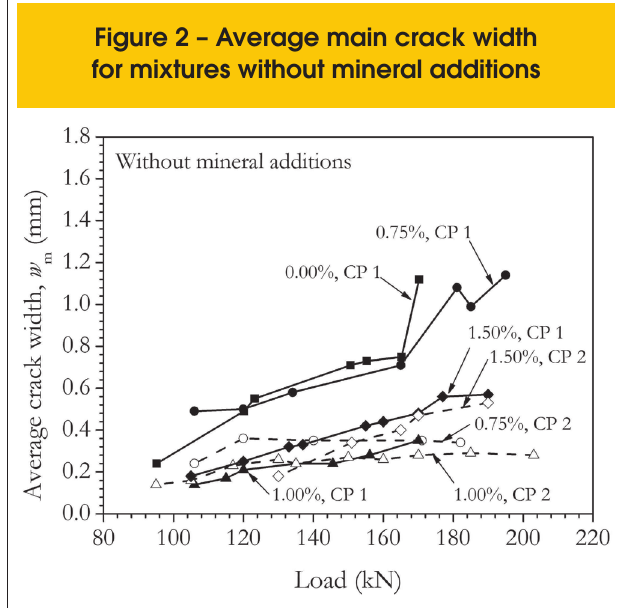
Figure 2 – Average main crack width for mixtures without mineral additions